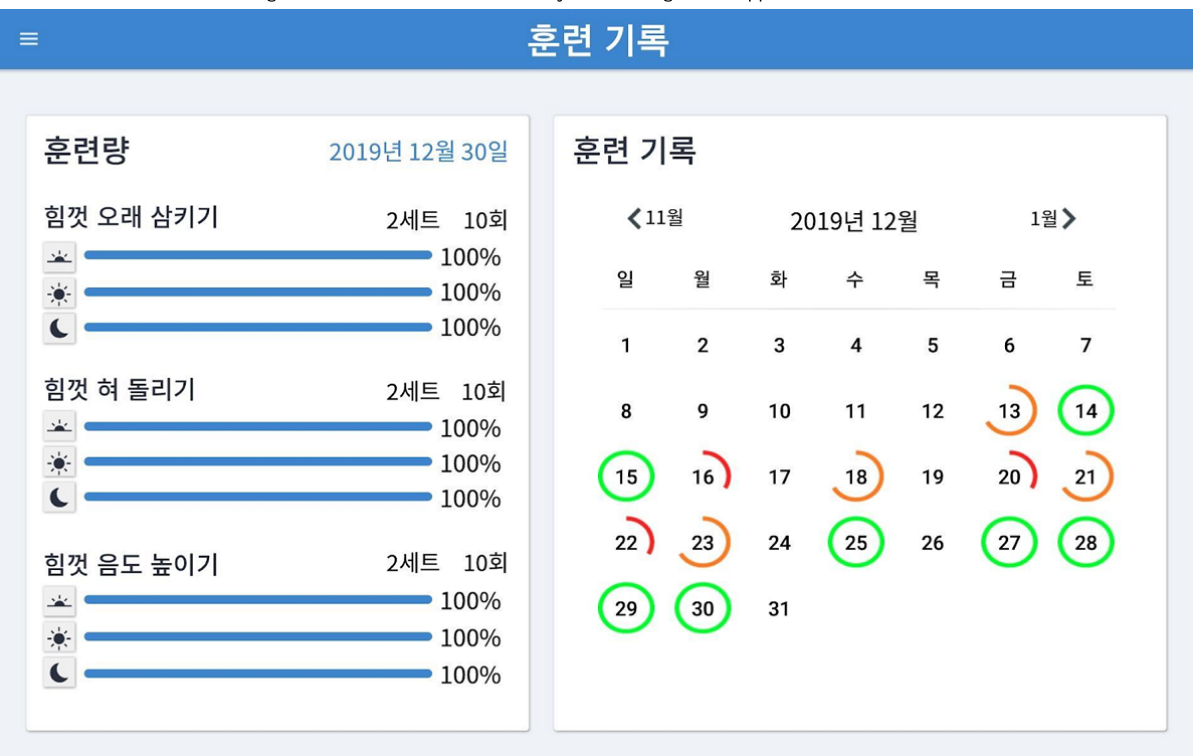
Figure 2. Screenshot of the Training Record screen of the 365 Healthy Swallowing Coach